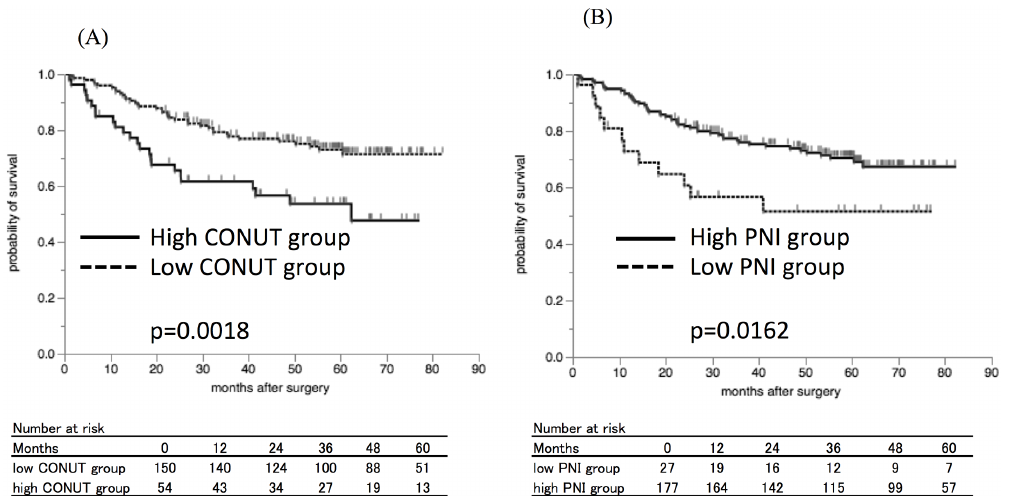
Fig 2. The Kaplan-Mayer survival curves for the relapse-free survival (RFS). A) The survival curves according to the CONUT score. The relapse-free survival rates were significantly worse in the high CONUT group compared to the low CONUT group (p = 0.0018). B) The survival curves according to the PNI. The relapse-free survival rates were significantly worse in the low PNI group compared to the high PNI group (p = 0.0162).